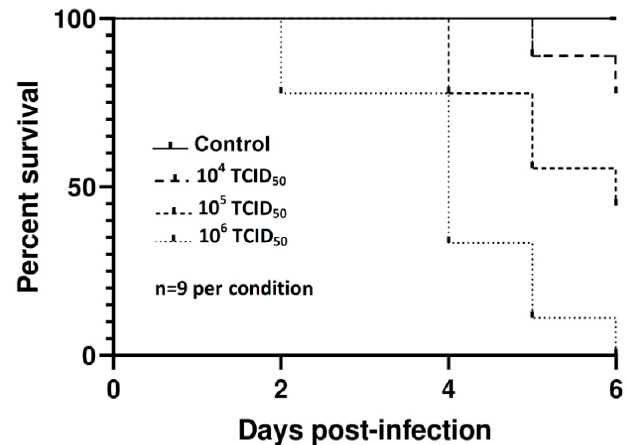
Figure 1. Kaplan–Meier survival curves for chicken embryos inoculated with three different doses of USU-BE-Seraing/2017 strain using the allantoic route.